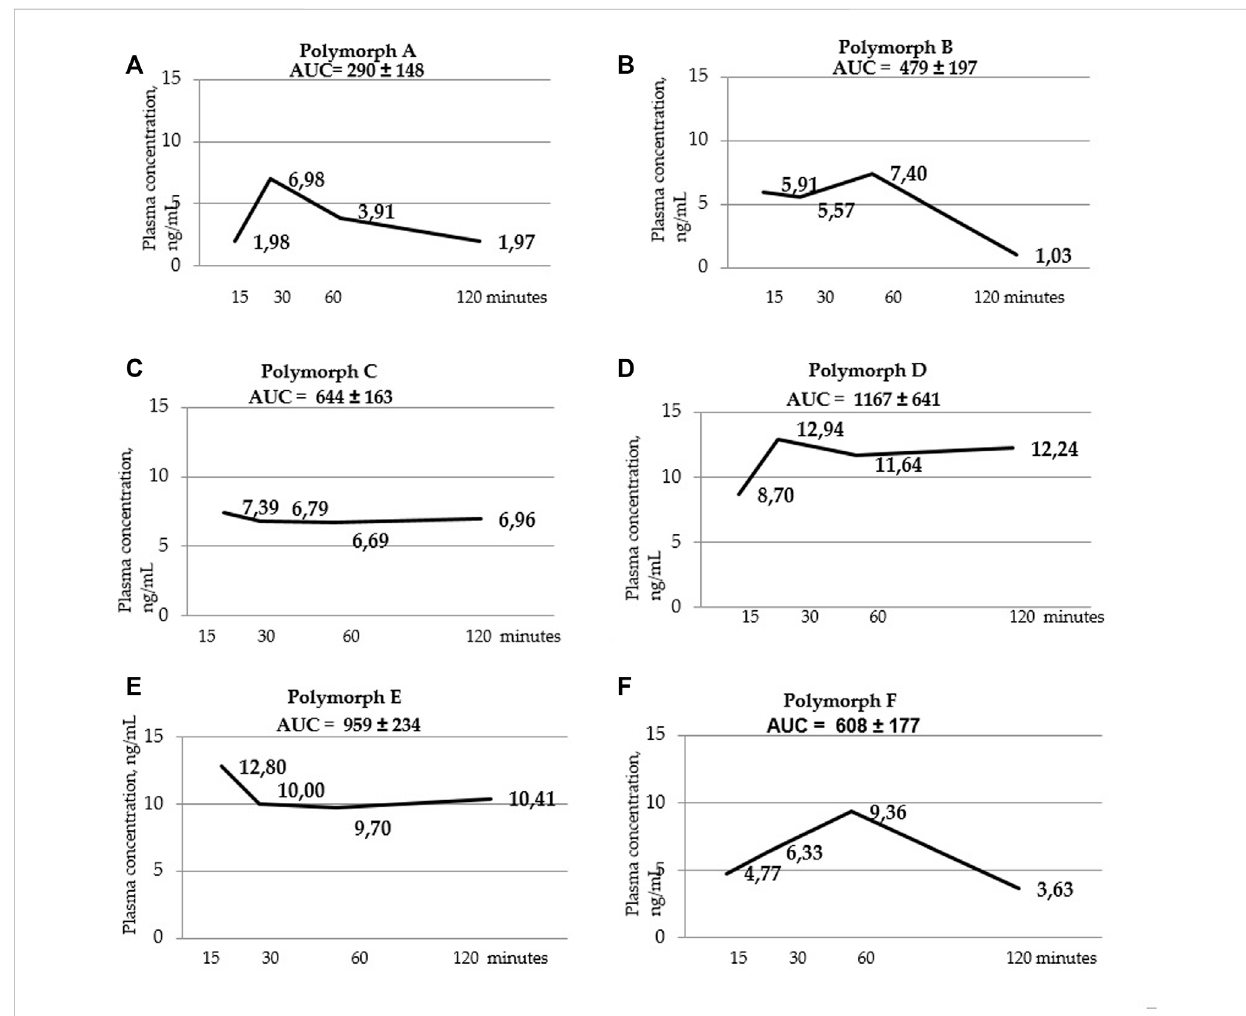
FIGURE 3 Blood serum concentration-time curves for polymorphs (A – F) . AUC values are listed at thetop of the graphs. AUC values were calculated using the trapezoid method for each individual animal, then the mean value and standard deviation of the AUC value for each polymorph were calculated.